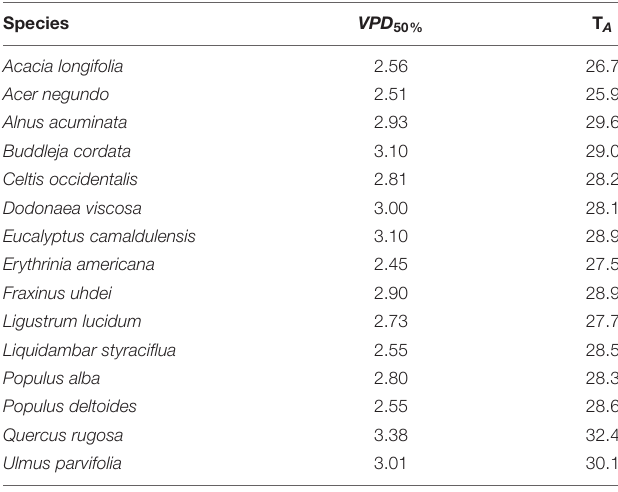
TABLE 5 | Maximum leaf water potential ( ψ MAX , MPa), optimum ψ interval value (